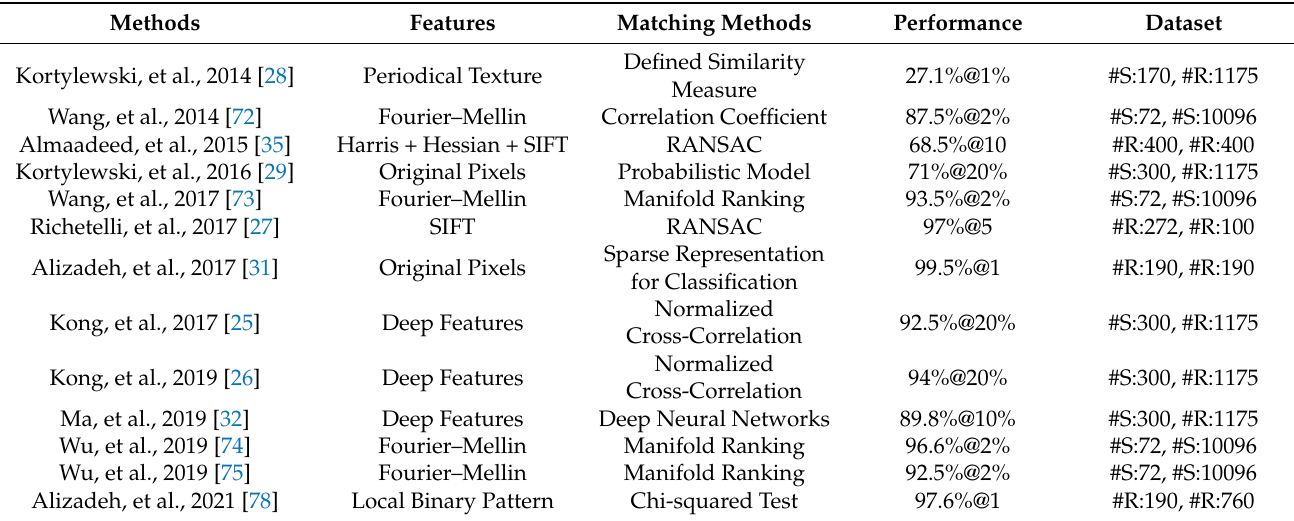
Table 1. Summary of the published shoeprint retrieval